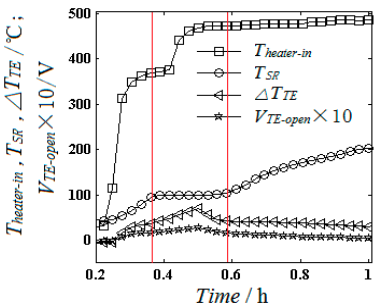
∆ T TE , and V TE-open with heater-in , T SR ,